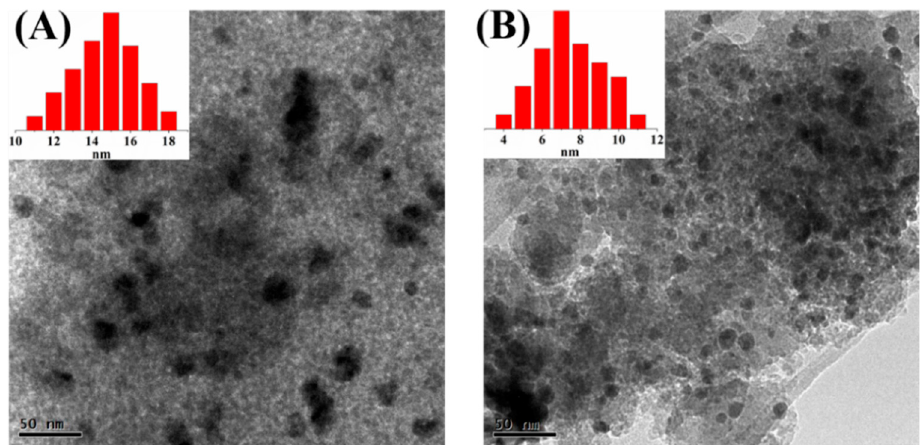
Figure 11. TEM images with the corresponding Cu particles size distribution diagrams of ( A ) Cu/SiO 2 and ( B ) 2B-Cu/SiO 2 catalysts after 150 h long-term catalytic test.